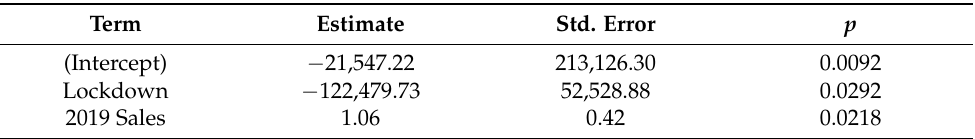
Table 4. Regression analysis for the overall change in phosphodiesterase type 5 inhibitors between